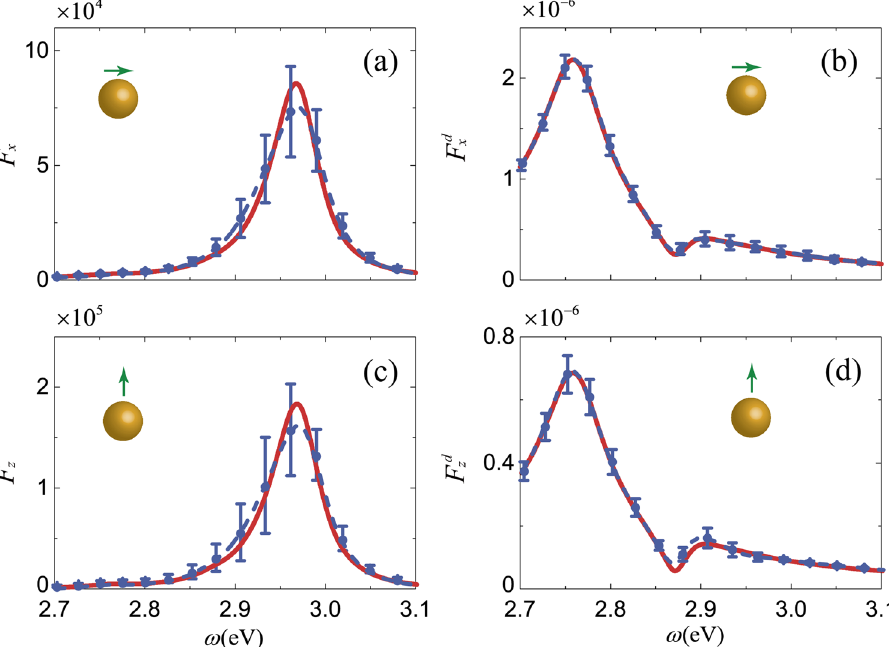
Figure 2. ( a ) F x averaged over 100 random realizations of rough MNPs (blue dashed line with error bar). F x of idealized MNP is shown for comparison (red solid line). Insert: green arrow indicates the dipole orientation. ( b ) Far-field enhancement F xd averaged over 100 random realizations of rough MNPs (blue dashed line with error bar). The result of idealized MNP is shown for comparison (red solid line). In ( a ) and ( b ) we use an x-oriented dipole. ( c ) and ( d ) are the same as ( a ) and ( b ) but for a z-oriented